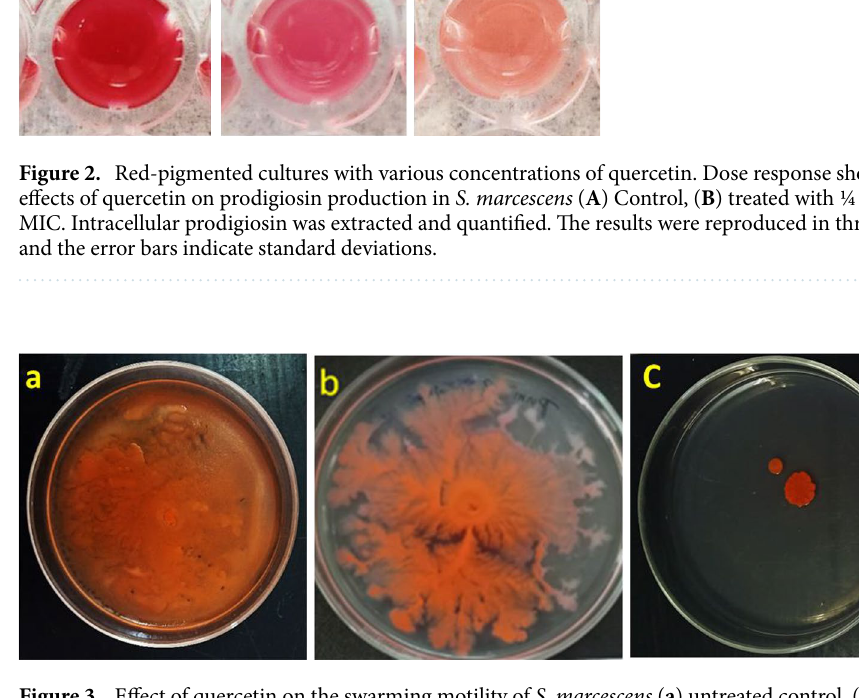
Figure 3. Effect of quercetin on the swarming motility of S. marcescens ( a ) untreated control, ( b ) ¼ MIC treated, ( c ) ½ MIC